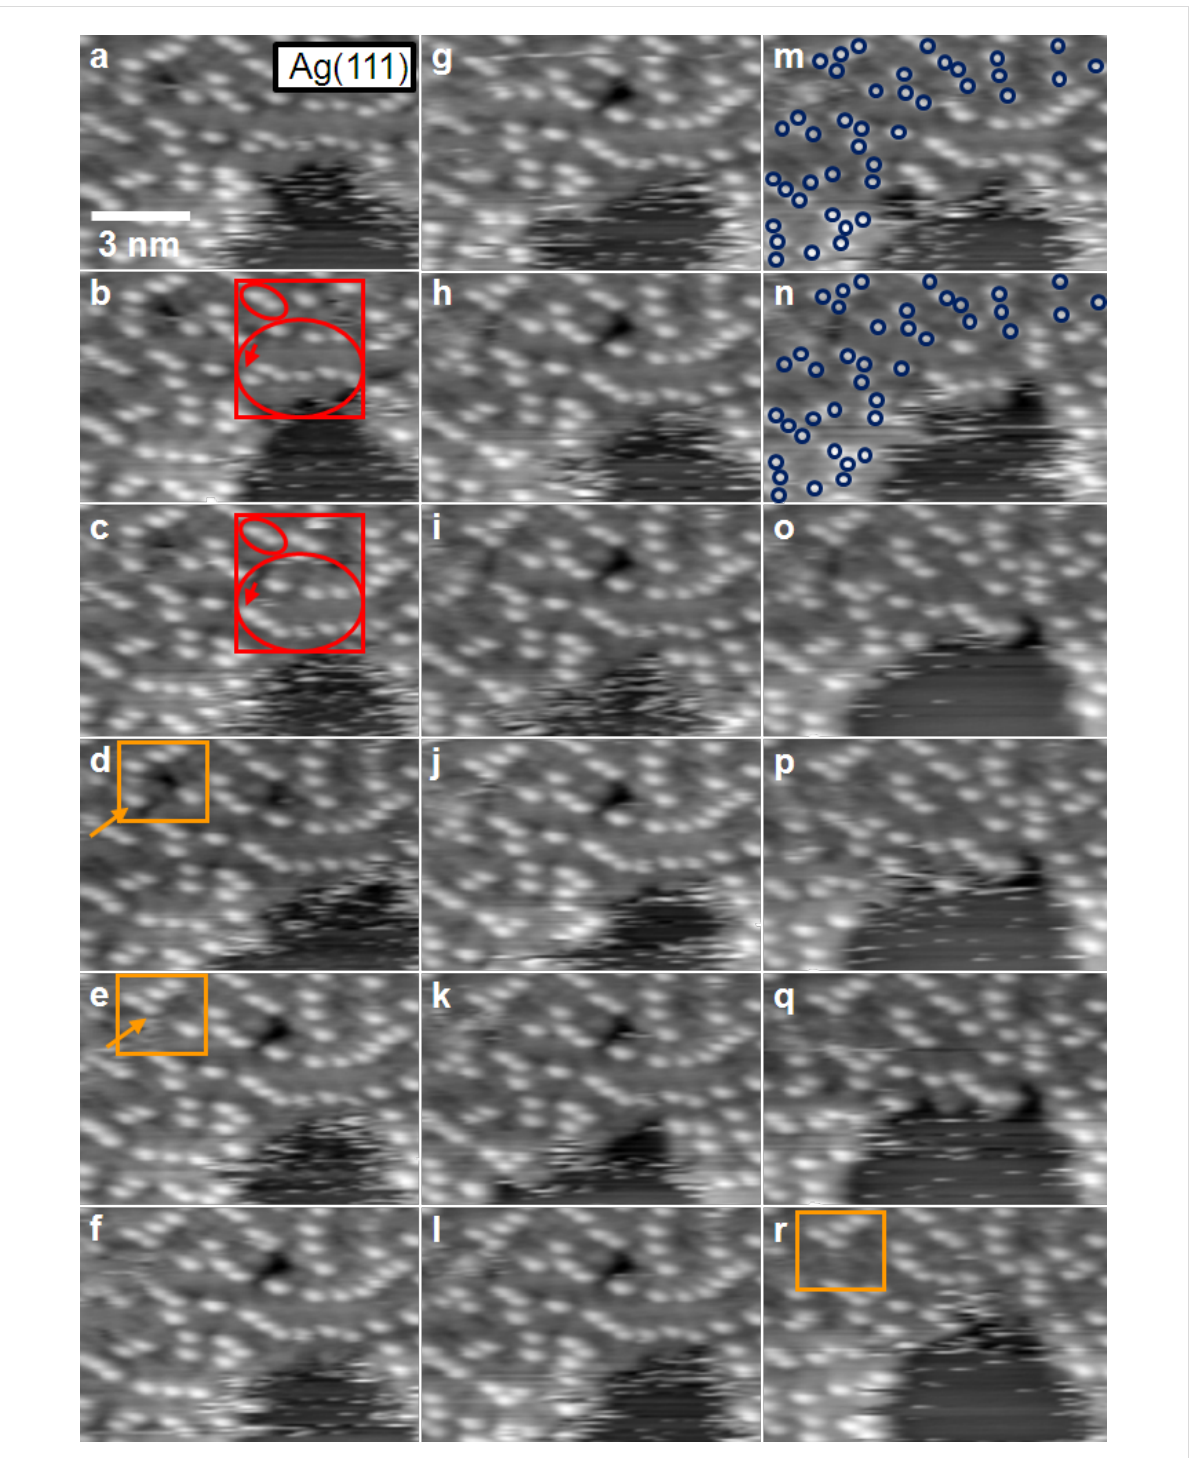
Figure 3: Sequence of STM images of [BMP][TFSA] adsorbed on Ag(111), acquired at 124 K, imaging the phase boundary between the 2D glass and 2D liquid phase (image-to-image time ≈ 11 s). Noisy features near the phase boundary and the successively changing phase boundary are indications for mobility at the phase boundary. A red frame in Figure 3b and 3c including two ovals marks two protrusions at stable positions (smaller oval), while the other protrusions in the larger oval shift to a lower position. The red arrow points out the changing position of a single protrusion. The orange boxes in Figure 3d and 3e highlight a molecular jump between two consecutive images. Subsequently, no motion is observed up to Figure 3r. The blue circles in Figure 3m and 3n show stable protrusions, while others at and close to the boundary between 2D glass structure and adsorbate free area clearly change positions ( T = 124 K, U T = − 0.76 V mV, I T = 50